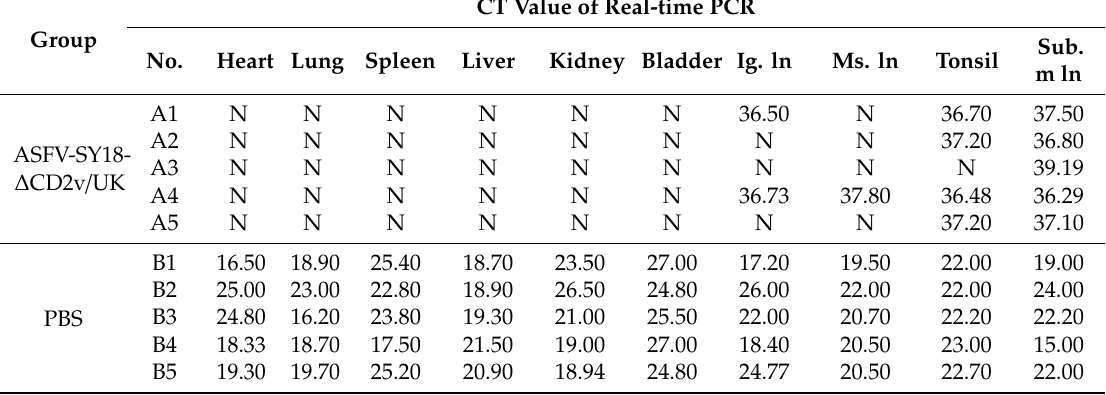
Table 4. Detection of ASFV genome in organs and lymph nodes of pigs following the challenge with ASFV-SY18.